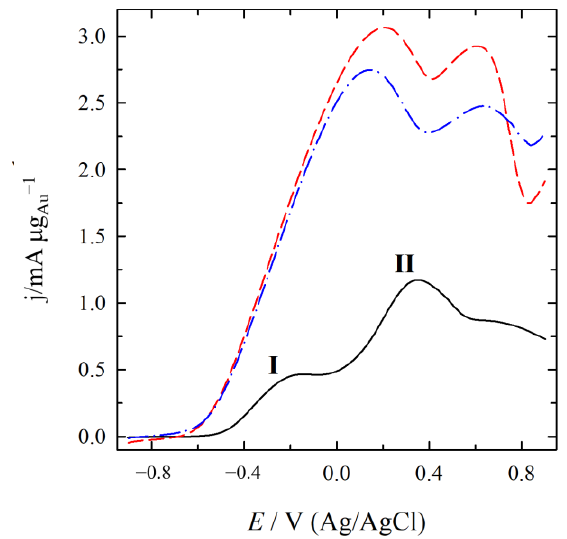
Figure 8. Au loading-normalized stabilized anodic scans recorded on Au(NiMo)/Ti-1, Au(NiMo)/Ti-2, and Au(NiMo)/Ti-3 catalysts in 0.1 M C 6 H 12 O 6 + 0.1 M NaOH at 25 °C at an electrode potential scan rate of 50 mV s − 1 .